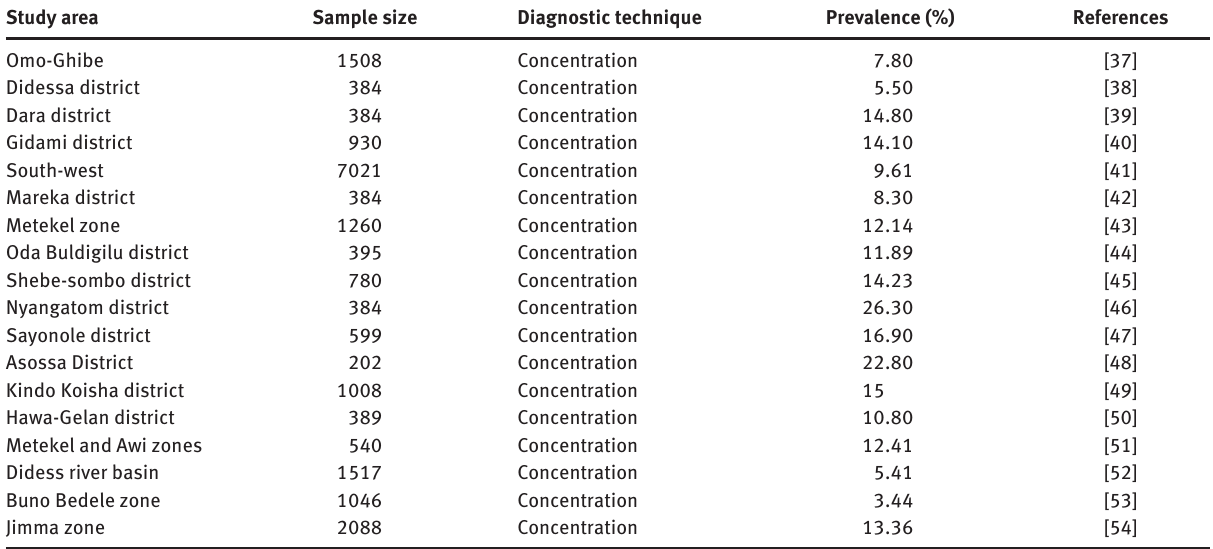
Table 1: Distribution of bovine trypanosomiasis in Ethiopia Study